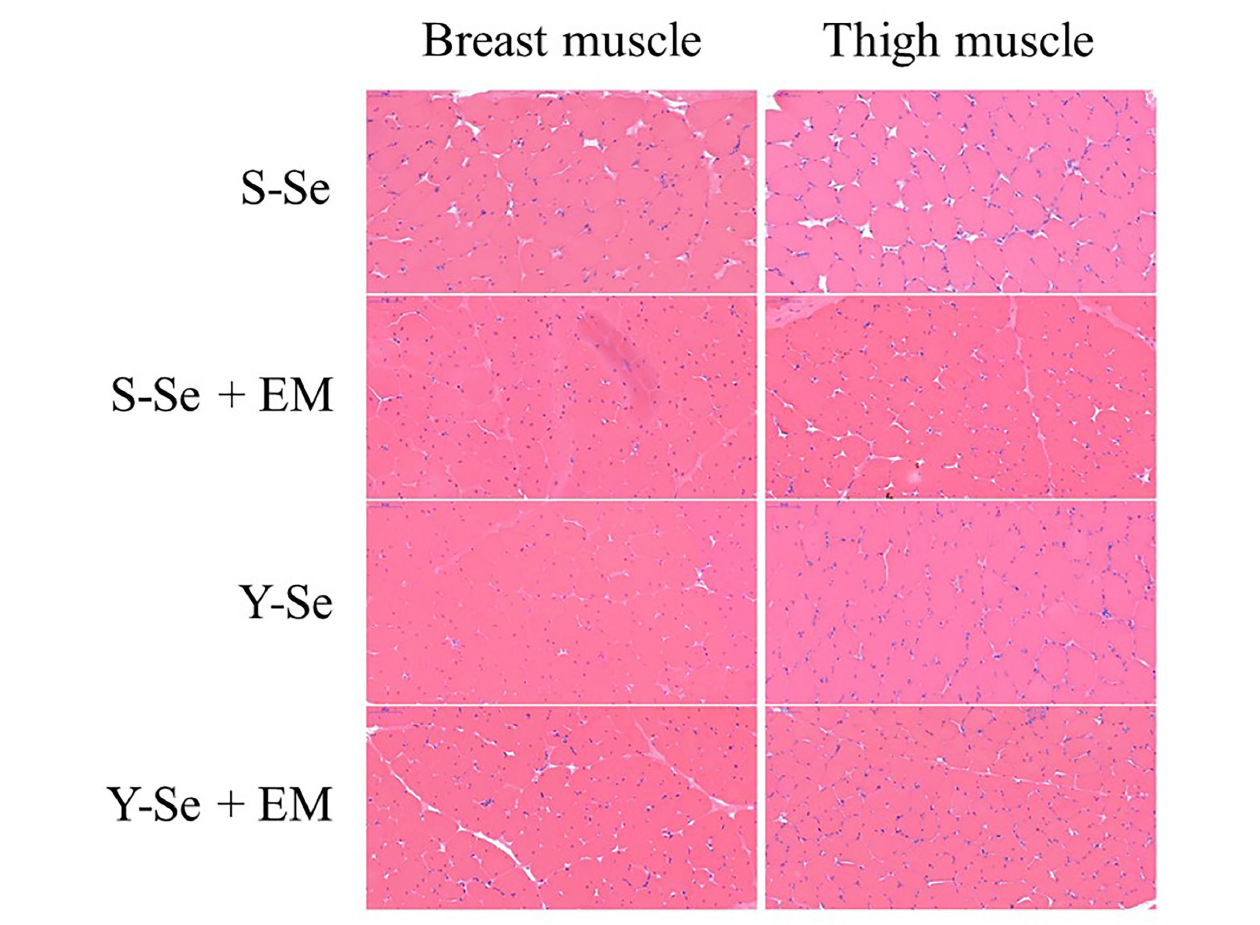
Figure 1 and Table 6 . In the breast muscle, there were no interactions between Se source and EM level regarding the muscle fiber characteristics ( p > 0.05). Compared with the broiler chickens fed I Se source, broiler chickens fed O Se source decreased the perimeter, cross-sectional area, and diameter, and improved the density ( p < 0.05). Broiler chickens supplied with H EMB level decreased the cross-sectional area and diameter, and enhanced the density, compared with the broiler chickens supplied with Z EMB level ( p < 0.05). In detail, the S-Se group had a greater cross-sectional area and diameter compared with the other groups ( p < 0.05). The Y-Se + EM group had a greater density compared with the S-Se and S-Se + EM groups, and the Y-Se group had a greater density compared with the S-Se group ( p < 0.05). perimeter ( p < 0.05). The a ∗